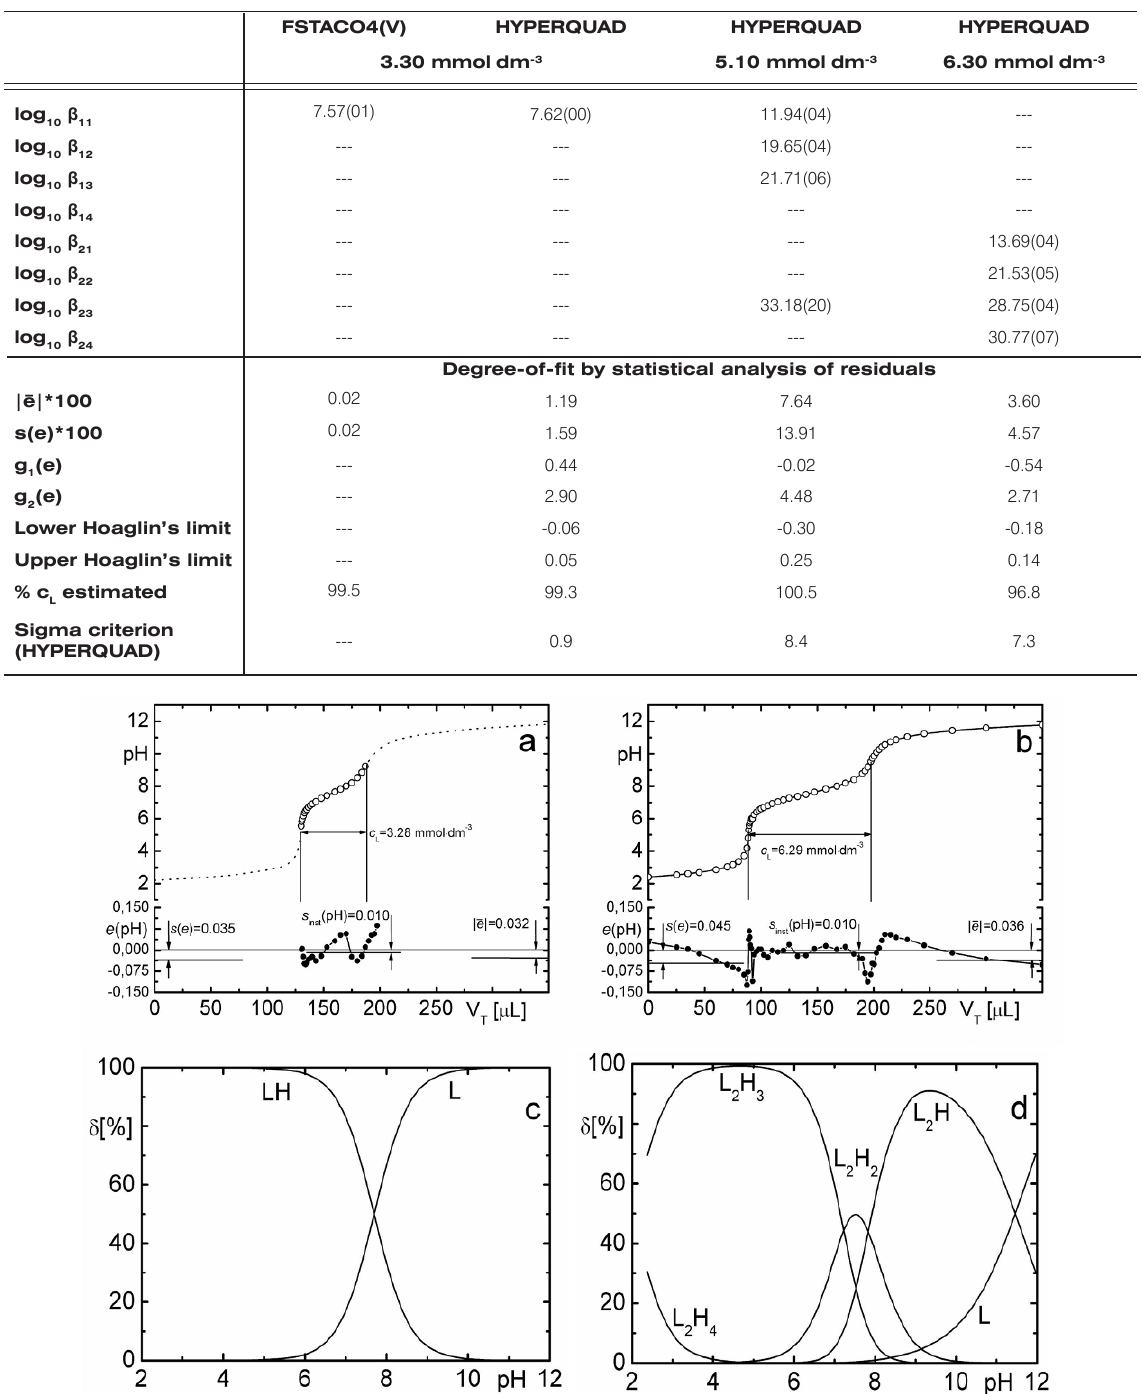
= 3.3 mmol dm -3 when monomers exist (a), and L , pH) co-ordinates and T (pH), Sigma, s ( e ), e after a regression search of the inst